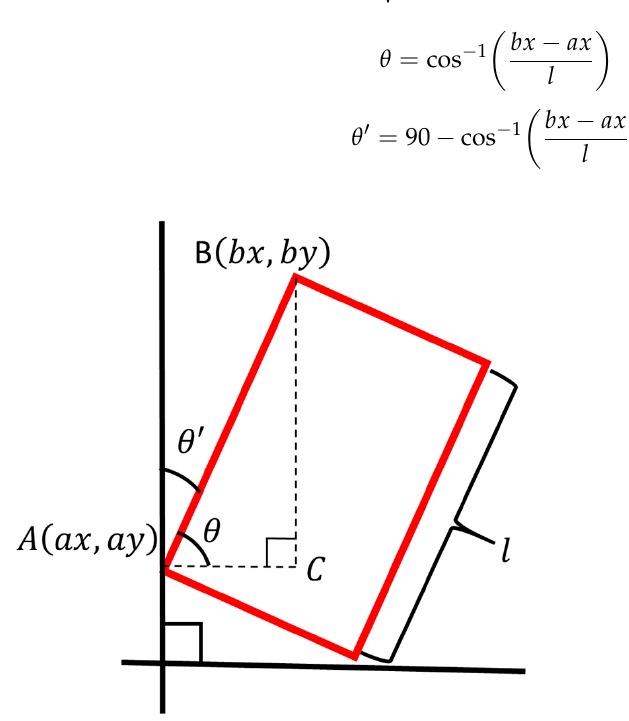
Figure 6. Calculation of the side length of the long axis.